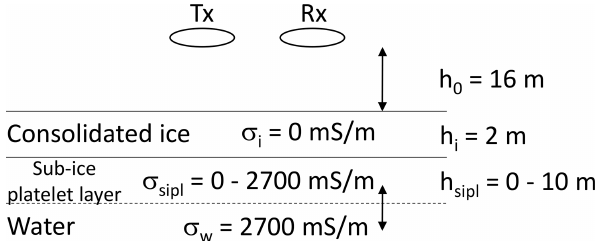
Figure 2. Schematic of the four-layer forward model to compute EM responses over sea ice underlain by a SIPL with variable thick- ness and conductivity. T x and Rx illustrate transmitting and re- ceiving coils, respectively. Instrument height h 0 = 16m, snow plus ice thickness h i = 2m, and water conductivity of 2700mSm − 1 are based on typical conditions during our surveys in McMurdo Sound.